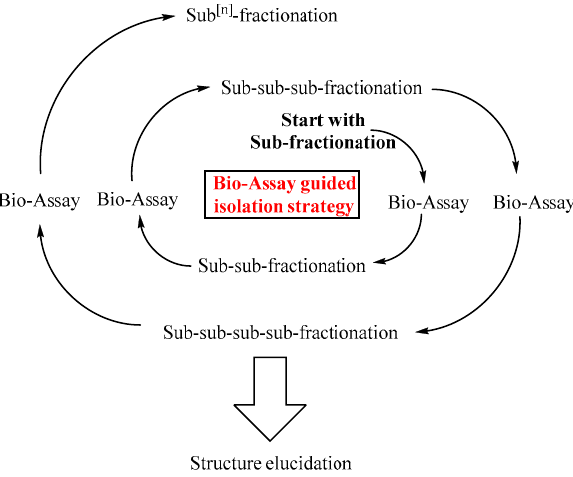
Figure 2. Bio-assay guided isolation of triterpene saponins. The bio-assay guided isolation allows the isolation and identification of biological active saponins. The raw extract is fractionated into sub-fractions, which are tested in suitable bio-assays. Bio-active sub-fractions are further purified resulting in a sub-sub-fractionation and so forth. Liquid chromatography–(tandem) mass spectrometry and high performance thin layer chromatography analyses are conducted at each point.